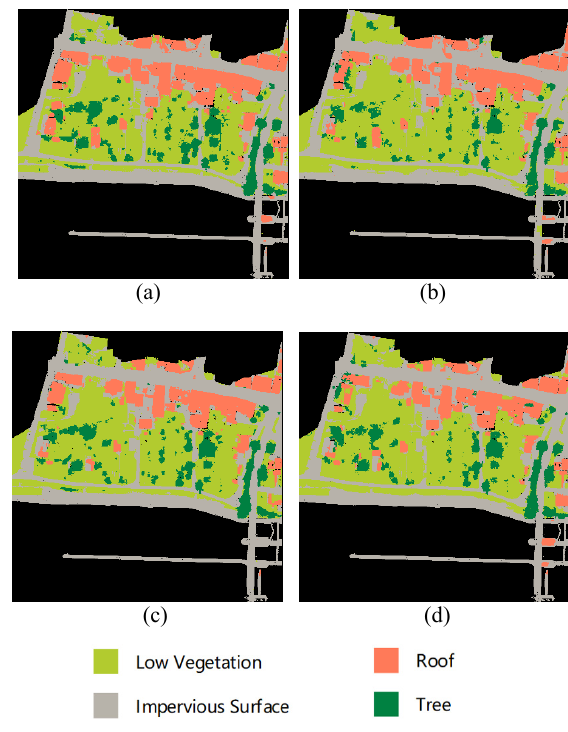
Figure 5 . Visualization of the test results on (a) the proposed network, (b) FCN, (c) Single-ST, and (d) PLF-ST.